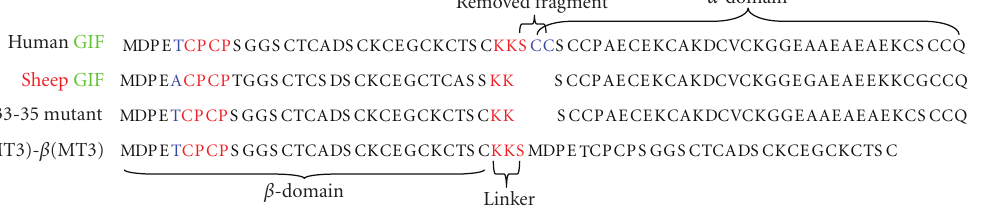
Figure 1: Amino acid sequence alignments of sheep MT3, human MT3, and its mutants.